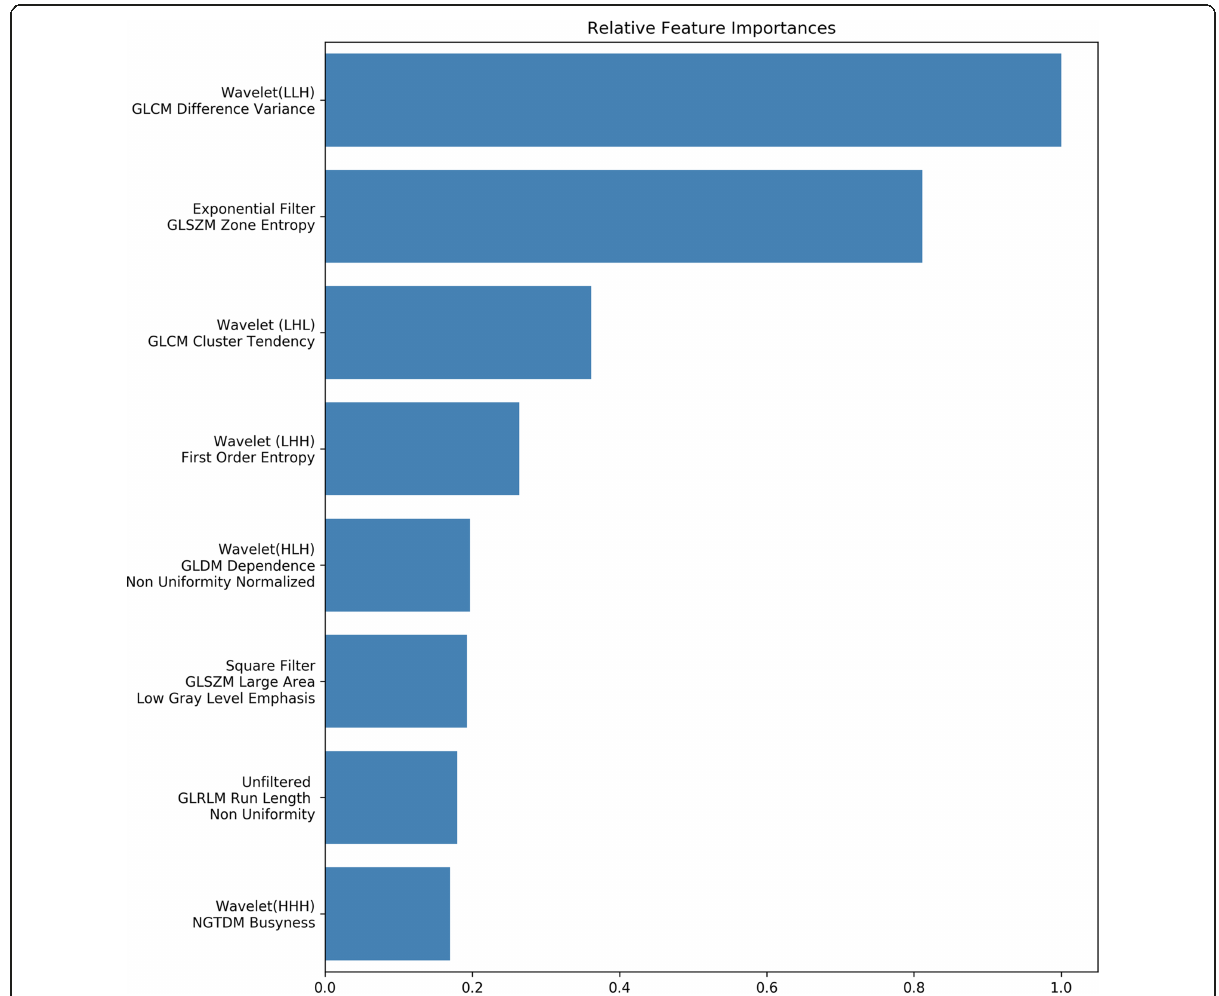
Fig. 4 Bar plot of the eight most important features for overall model performance as determined by the random forest model by assessment of Gini impurity decrease and recursive feature elimination. Feature importance has been normalized to the most important feature. The features, in order of descending importance are as follows: (1) gray-level co-occurrence matrix difference variance, (2) gray-level zone size matrix zone entropy, (3) gray-level co-occurrence matrix cluster tendency, (4) first-order entropy, (5) gray-level difference method dependence non-uniformity normalized, (6) gray-level zone size matrix large area low gray-level emphasis, (7) gray-level run-length matrix run-length non-uniformity, and (8) neighbourhood gray tone difference matrix busyness. Of note, features 1 – 5 are associated with image heterogeneity and only one (6) associated with the proportion of large zones with low gray values within the